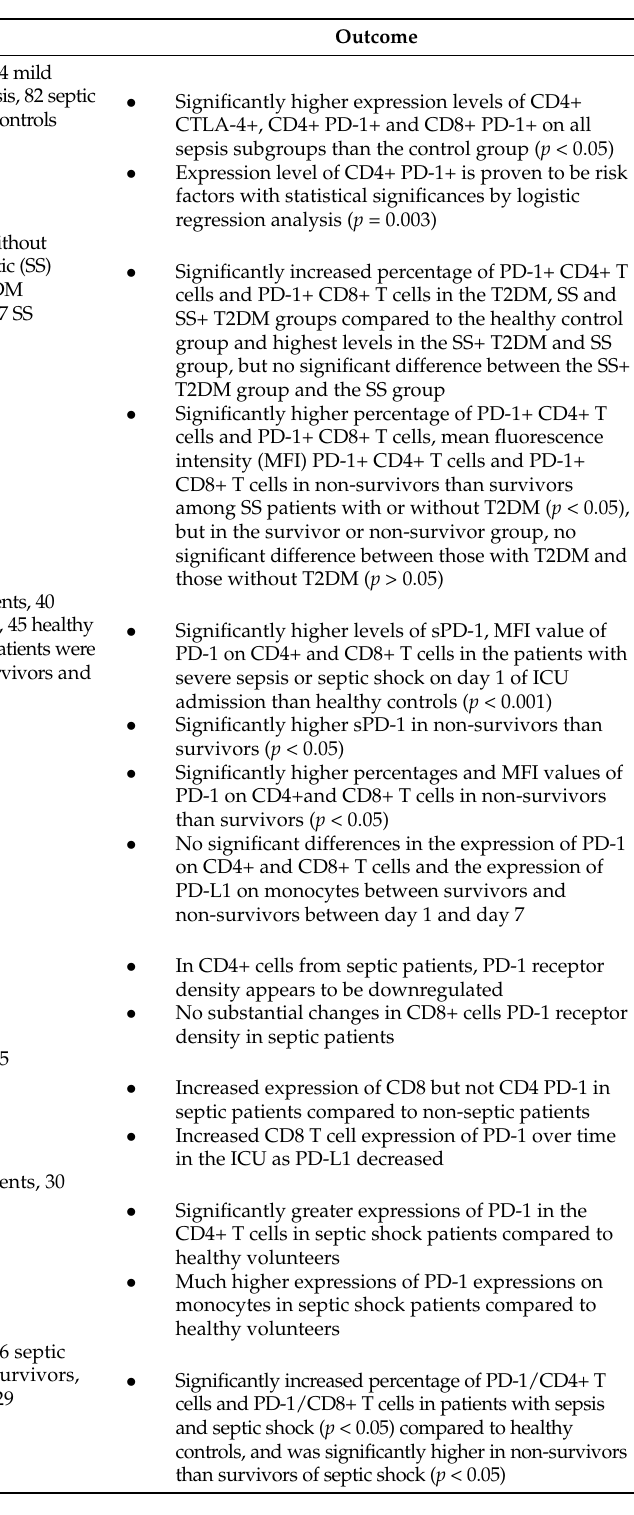
Table 2. Study characteristics of expression level and concentration of PD-1 protein in septic